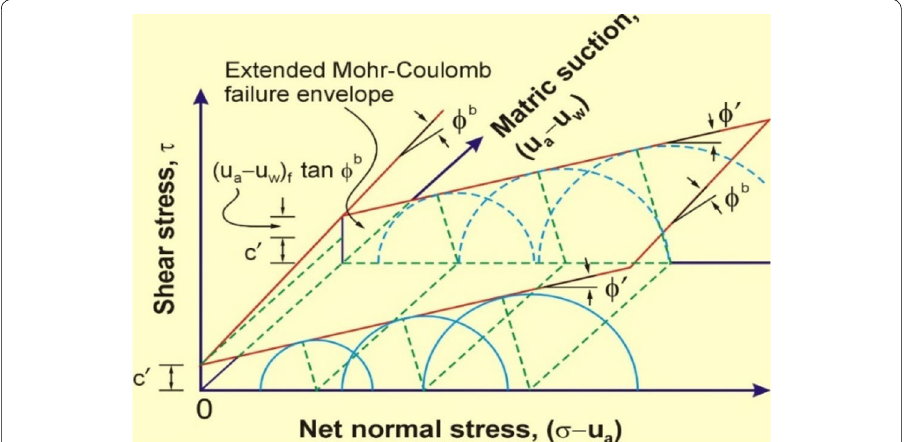
Fig. 3 Extended Mohr–Coulomb failure envelope (Fredlund and Rahardjo